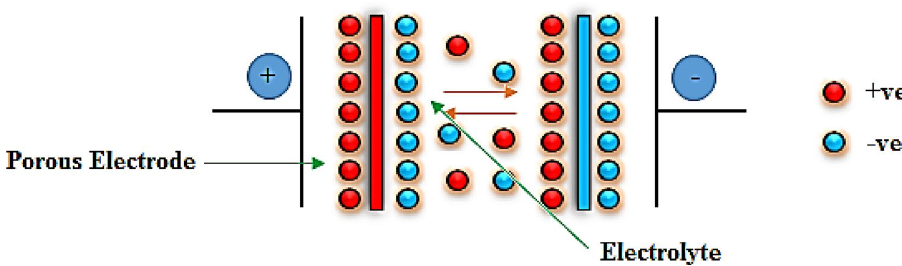
Fig. 1 Electric double layer capacitor